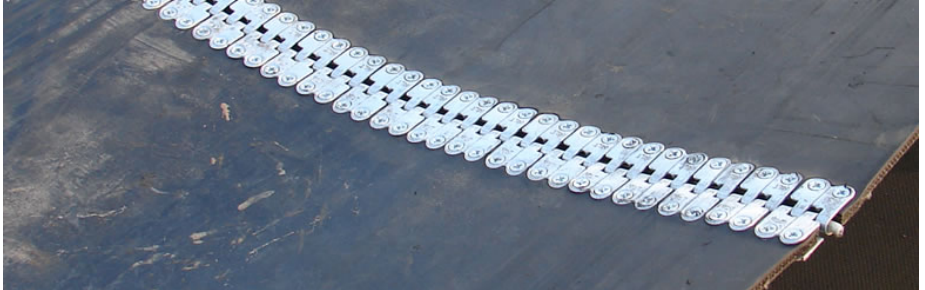
Figure 7. Belt joint using a metal